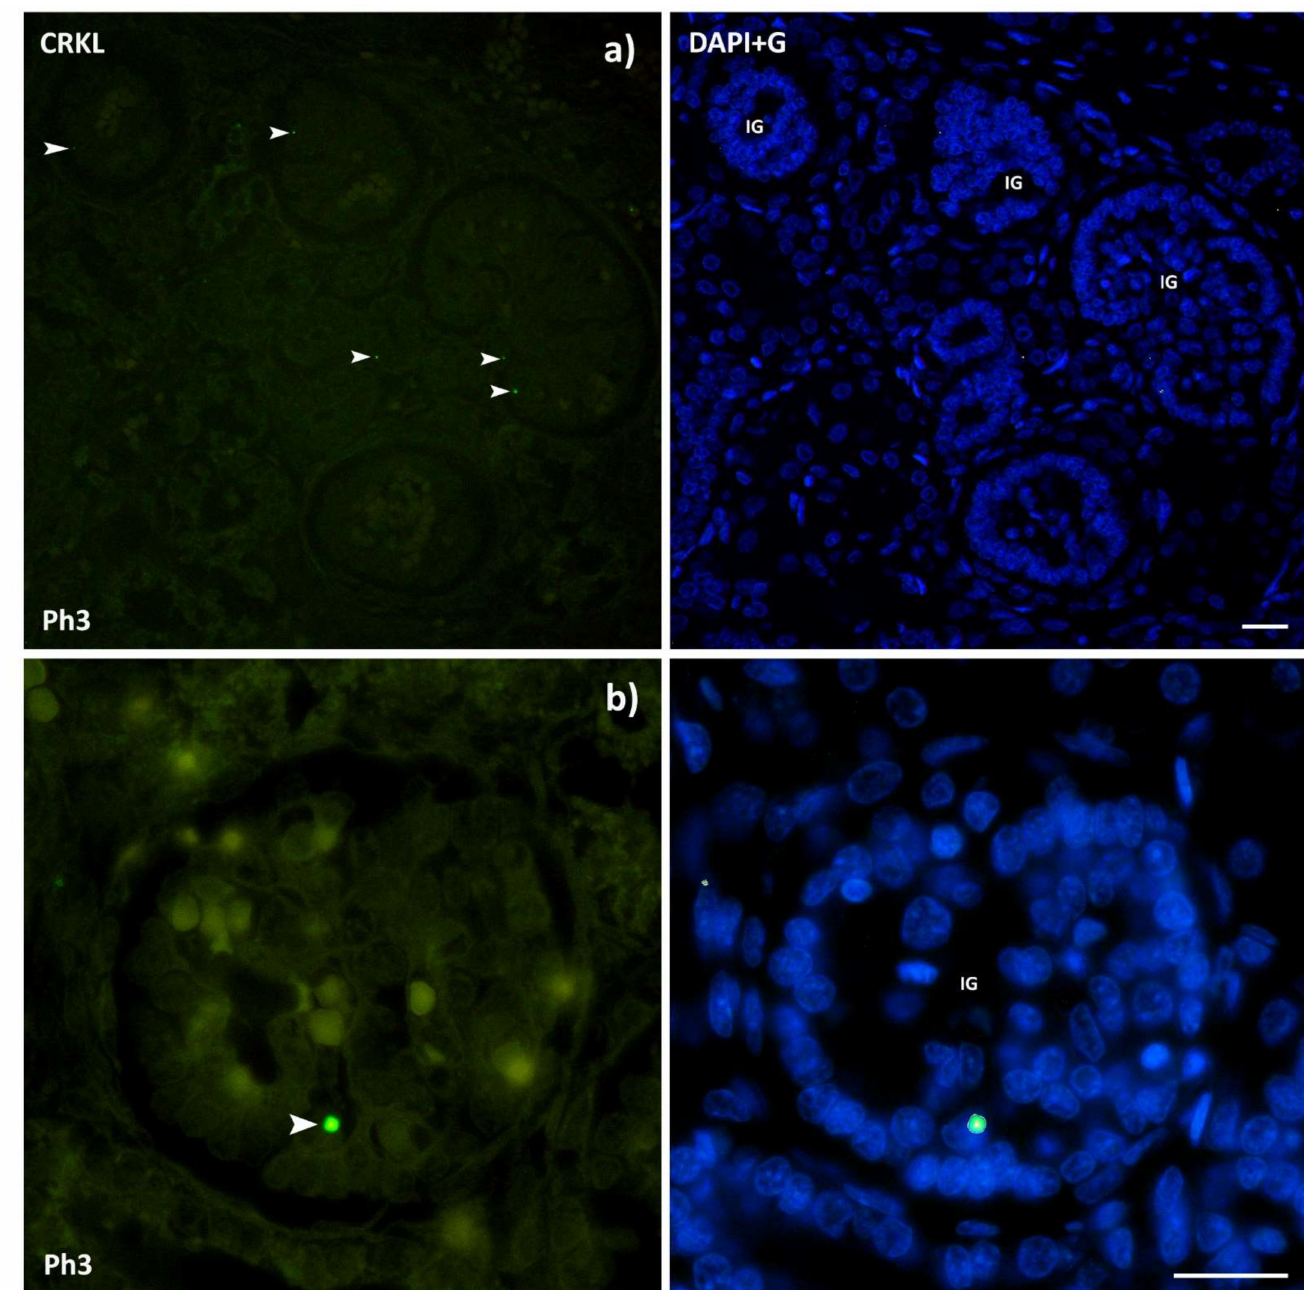
Figure 10. Immunofluorescence staining of human fetal kidneys with the CRKL (green) marker and the isolated signal with DAPI nuclear staining. Expression of CRKL (arrows), immature glomeruli (IG). The CRKL positive cells displayed strong punctate staining with mainly a single positive cell in a structure with the signal being localized within the nucleus. Image ( a ) was taken on magnification 40 × , while ( b ) was taken on 100 × . Scale bar is 20 µ